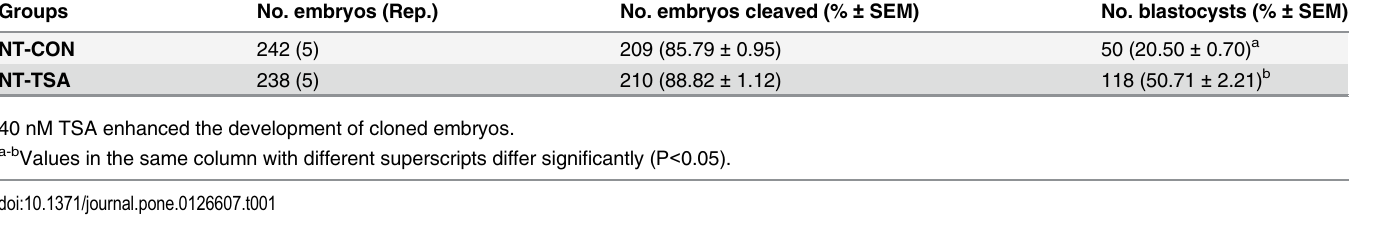
Table 1. In vitro development of cloned embryos treated with TSA. Groups No. embryos (Rep.)